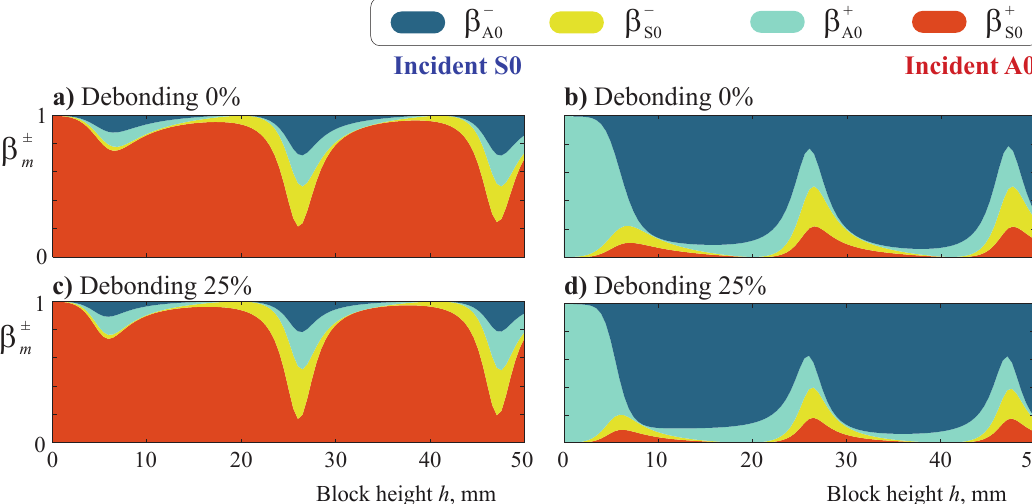
Figure 12. The transmission and reflection coefficients β ± m ( h ) for the incident S0 ( a , c ) and A0 ( b , d ) modes scattered by the obstacle of height h and width w = 5 mm at frequency f = 25 kHz with a debonding rate of 0% at a = 0 ( a , b ) and a debonding rate of 25% at a = 1.25 mm ( c , d